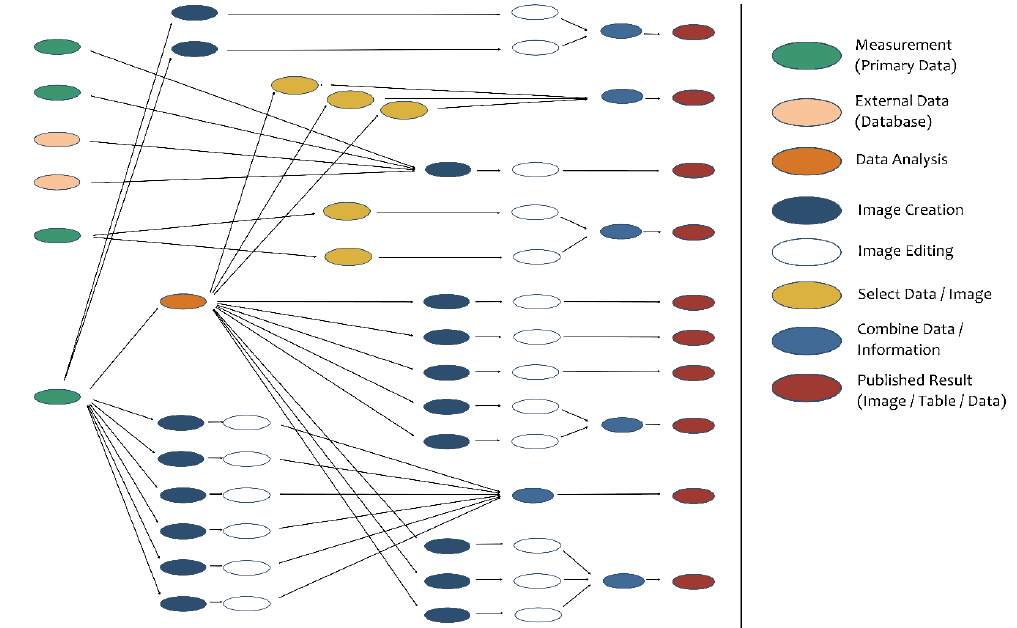
Figure 4. Provenance of published research data for defined publication (Schematic Overview, You can see a complete version in Supplementary).